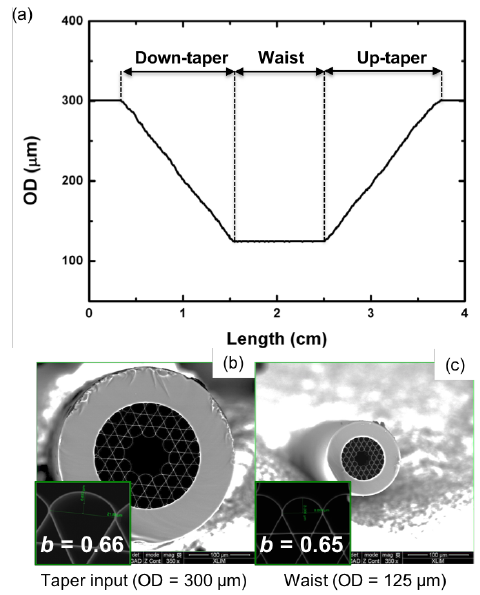
versus length; (b) Cross-section of untapered and (c) tapered kagome HCPCF fiber at the waist region. Inset: zoom in the core